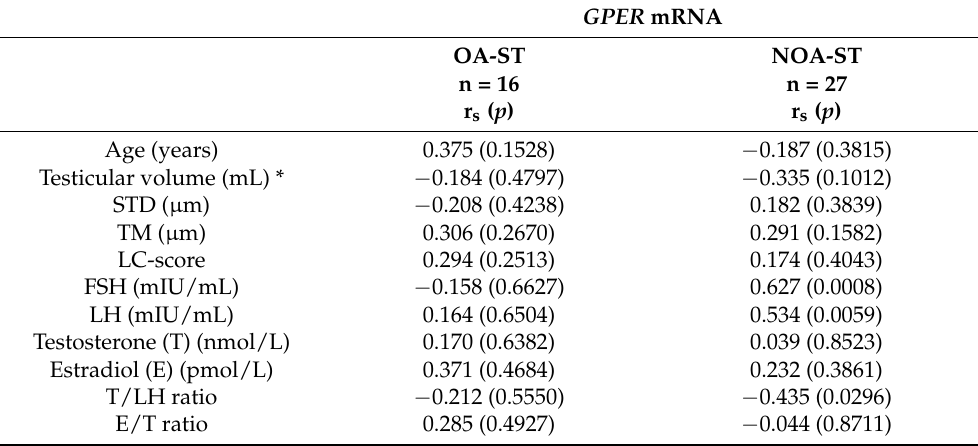
Table 6. Spearman’s rank correlation (r s ) between the GPER -ST mRNA expression level and age, parameters of histological evaluation and hormonal levels in OA-ST and NOA-ST groups.